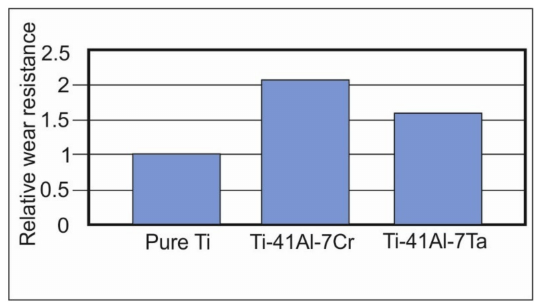
Figure 5. The relative wear resistance of the intermetallic layers obtained on pure titanium workpieces. After the tests, analysis of the friction surfaces revealed a surface morphology that typically forms during abrasive wear. Grooves from the abrasive particles are clearly seen in Figure 6. The roughness of the surfaces of different samples after the tests slightly varied. The surface of the pure titanium was characterized by the maximum roughness (Ra = 2.1 µ m). The cladding layers alloyed with chromium and tantalum had a roughness Ra = 1.7 and Ra = 1.9 µ m, respectively. Thus, the surface of the Ti-41Al-7Ta intermetallic alloy after the wear test was rougher in comparison with the Cr-containing intermetallic layer.